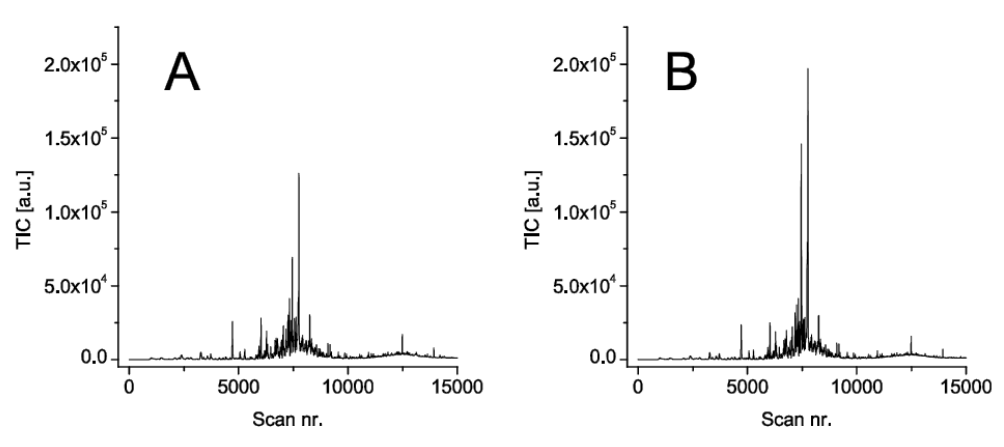
Figure 1. Typical chromatographic profiles obtained from analysing the air in a greenhouse. Data were obtained in week nr. 6; before (A), and directly after (B) damage of tomato plants (TIC = total ion